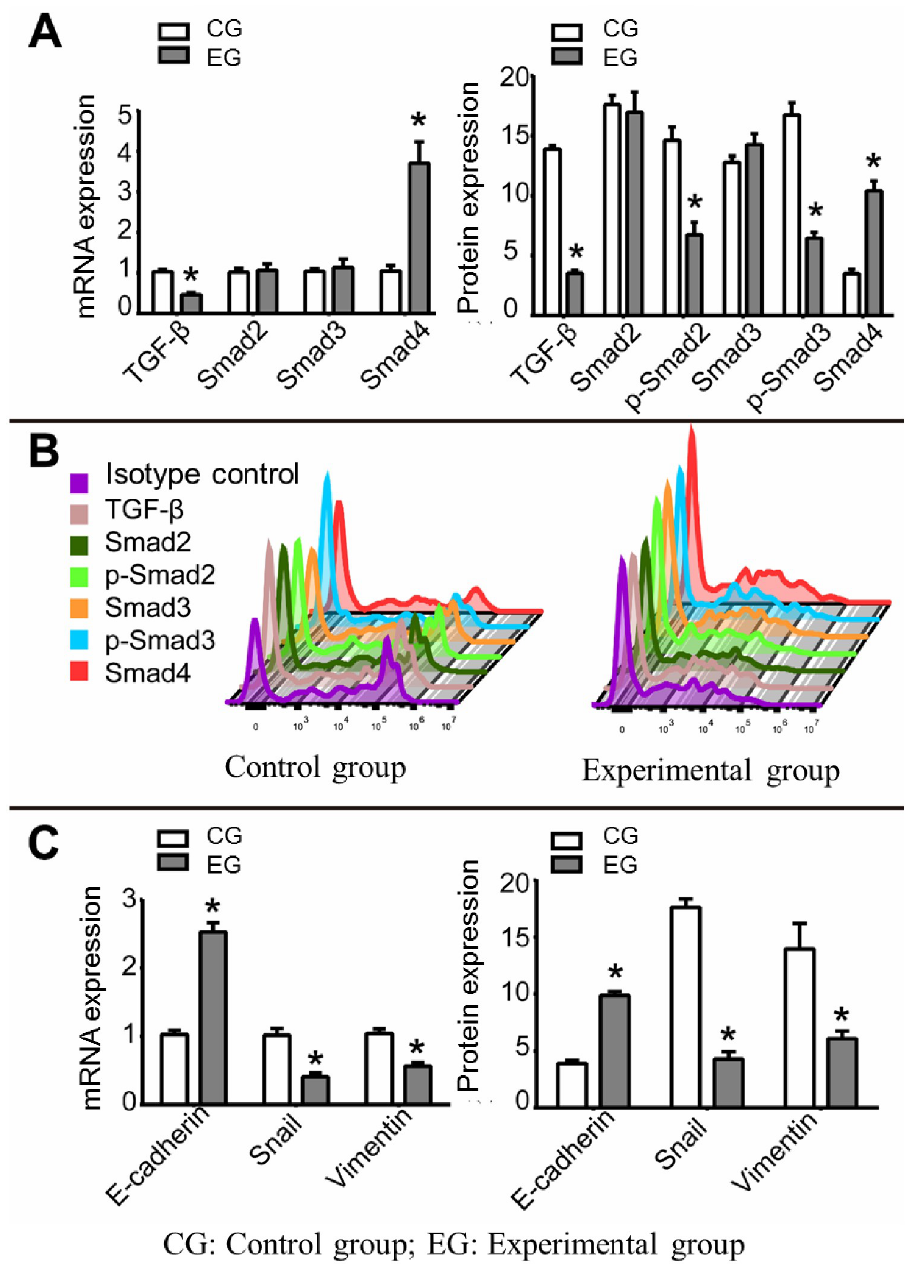
Fig 3. Effect of SB525334 on TGF- β pathway and EMT in CSCs. (A) mRNA expression (A) and protein expression (B) levels of TGF- β , Smad2, p-Smad2, Smad3, p-Smad3, and Smad4 in CSCs with and without the use of SB525334; (C) mRNA and protein expressions of E-cadherin, Snail and Vimentin in CSCs with and without the use of SB525334; � P < 0.05. https://doi.org/10.1371/journal.pone.0230230.g003 expression in ovarian cancer CSCs. The qRT-PCR results (Fig 3C) show that the relative mRNA expression levels of E-cadherin, Snail and Vimentin in the experimental group and the control group are 2.53 ± 0.14, 0.41 ± 0.06, 0.56 ± 0.06 and 1.03 ± 0.06, 1.02 ± 0.1, 1.04 ± 0.07 (t = 17.45, 9.54, 9.64; P = 0.0001, 0.0007, 0.0006), respectively. The protein data from flow